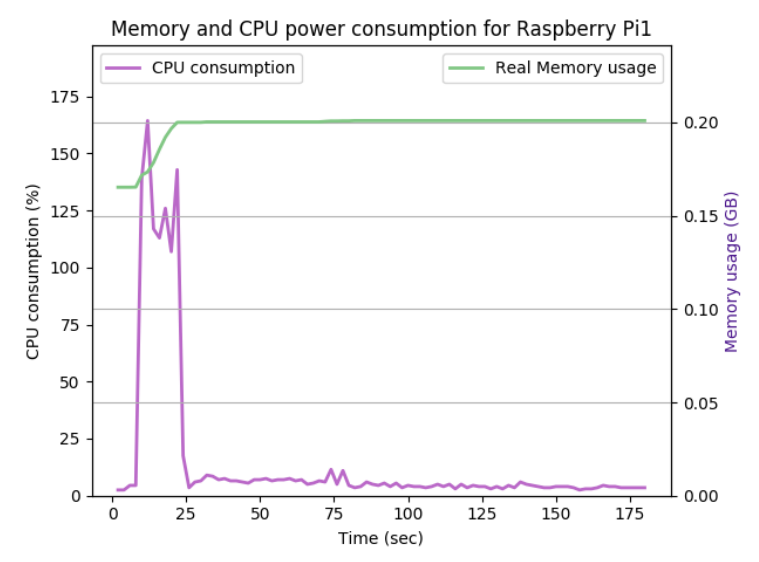
Figure 16. The CPU and memory utilization of the Raspberry Pi device using